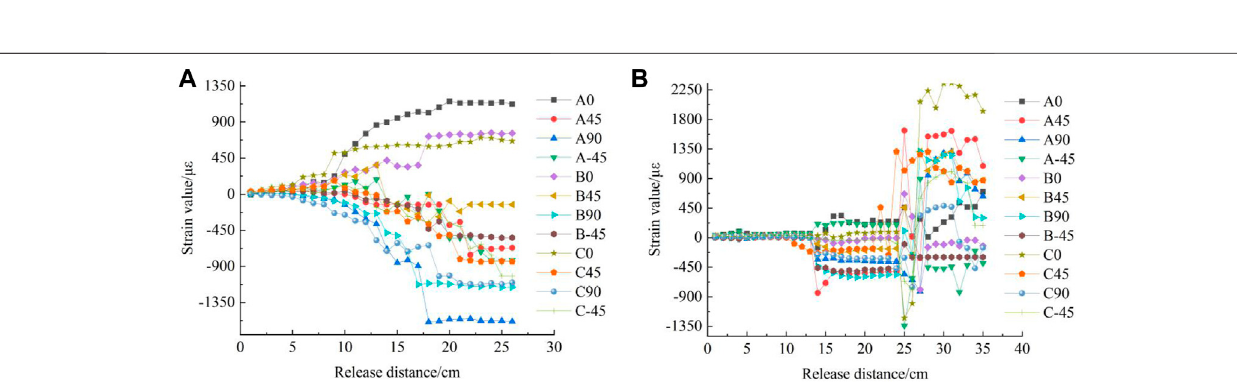
Frontiers in Earth Science |